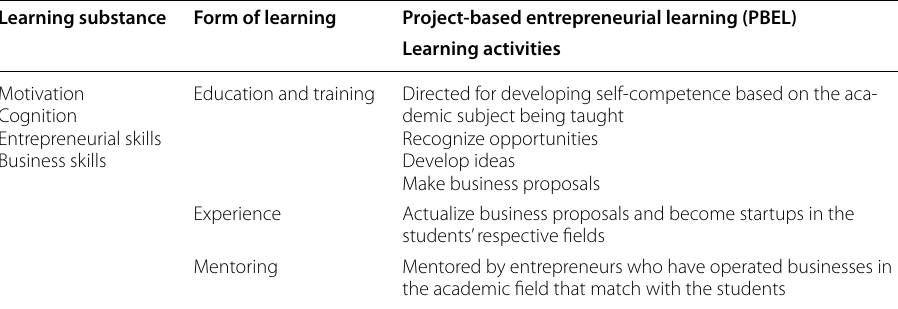
Table 1 ELM and project-based learning combined model